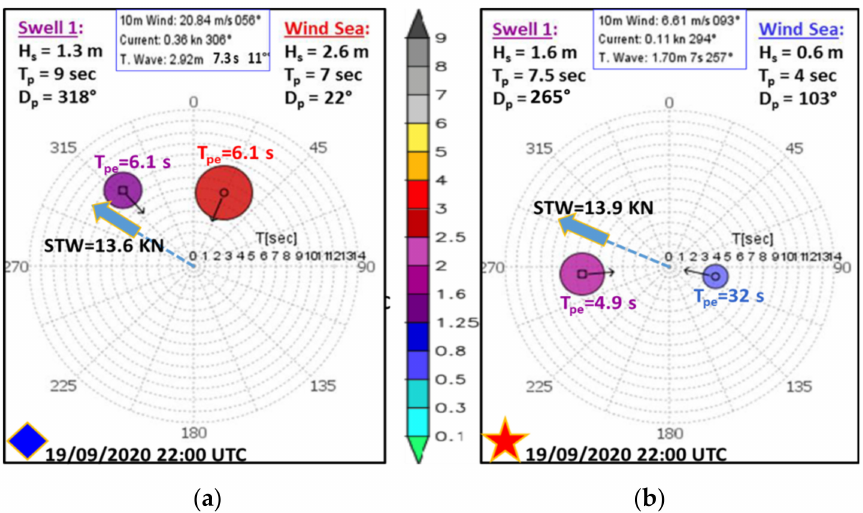
Figure 12. Spectral partitions visualization for 19/09/2020 at 22:00 UTC seaway state in correspon- dence of the two locations indicated in Figure 13 with: ( a ) blue diamond, ( b ) red star. In addition, shown are the encounter period values for all the wave components, for two, respectively, tested values of the ship